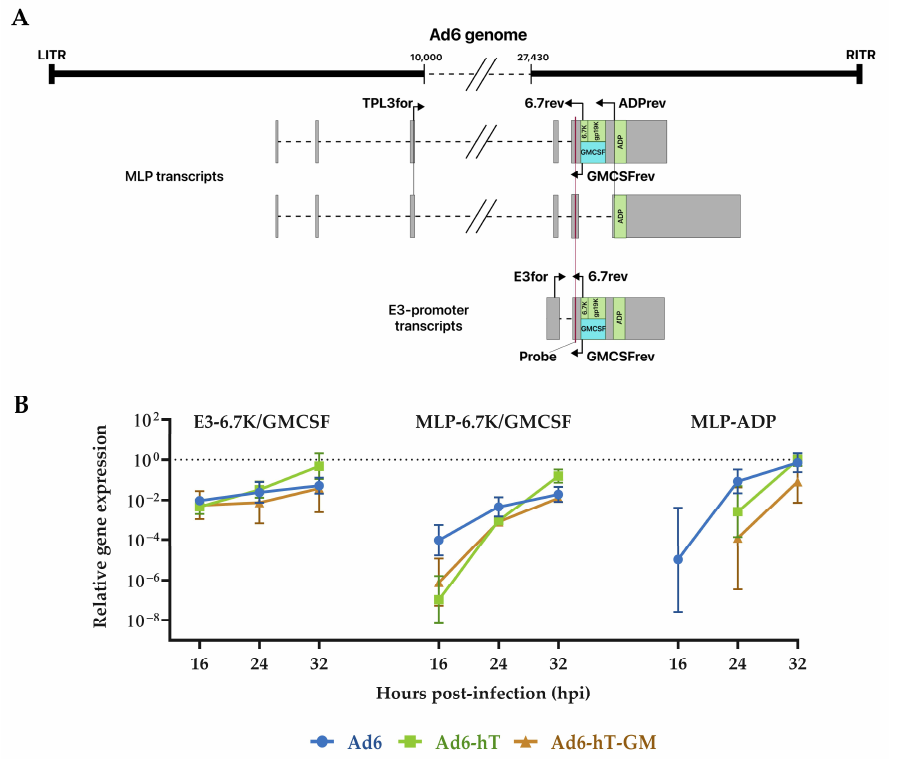
Figure 4. Analysis of E3-coded genes expression. ( A ) Scheme of E3 mRNA transcripts and primer design. ( B ) The relative expression of E3-6.7K, ADP genes and GM-CSF transgene. A549 cells were infected with Ad6, Ad6-hT, and Ad6-hT-GM with MOI = 100 vp/cell, total RNA was collected, and mRNA transcripts copy number was assessed by RT-PCR and normalized to the GAPDH expression level. E3-6.7K/GMCSF–RT-PCR results with primers E3for and 6.7rev/GMCSFrev for Ad6, Ad-hT/Ad6-hT-GM respectively, MLP-6.7K/GMCSF–TPL3for and 6.7rev/GMCSFrev, MLP-ADP–